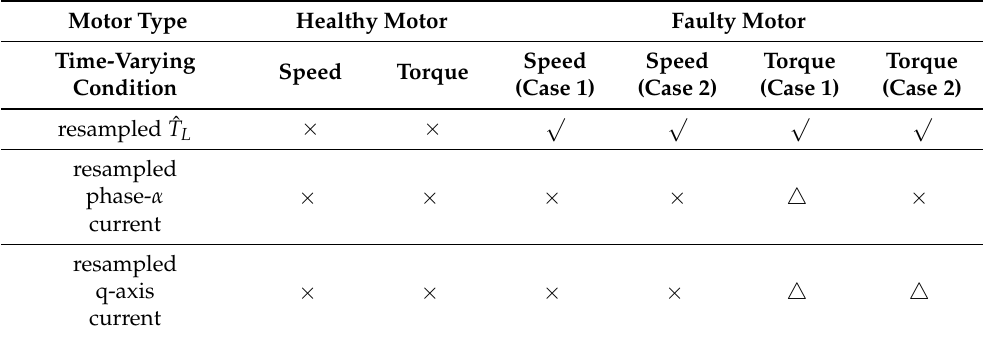
Table 3. Summary of the order analysis